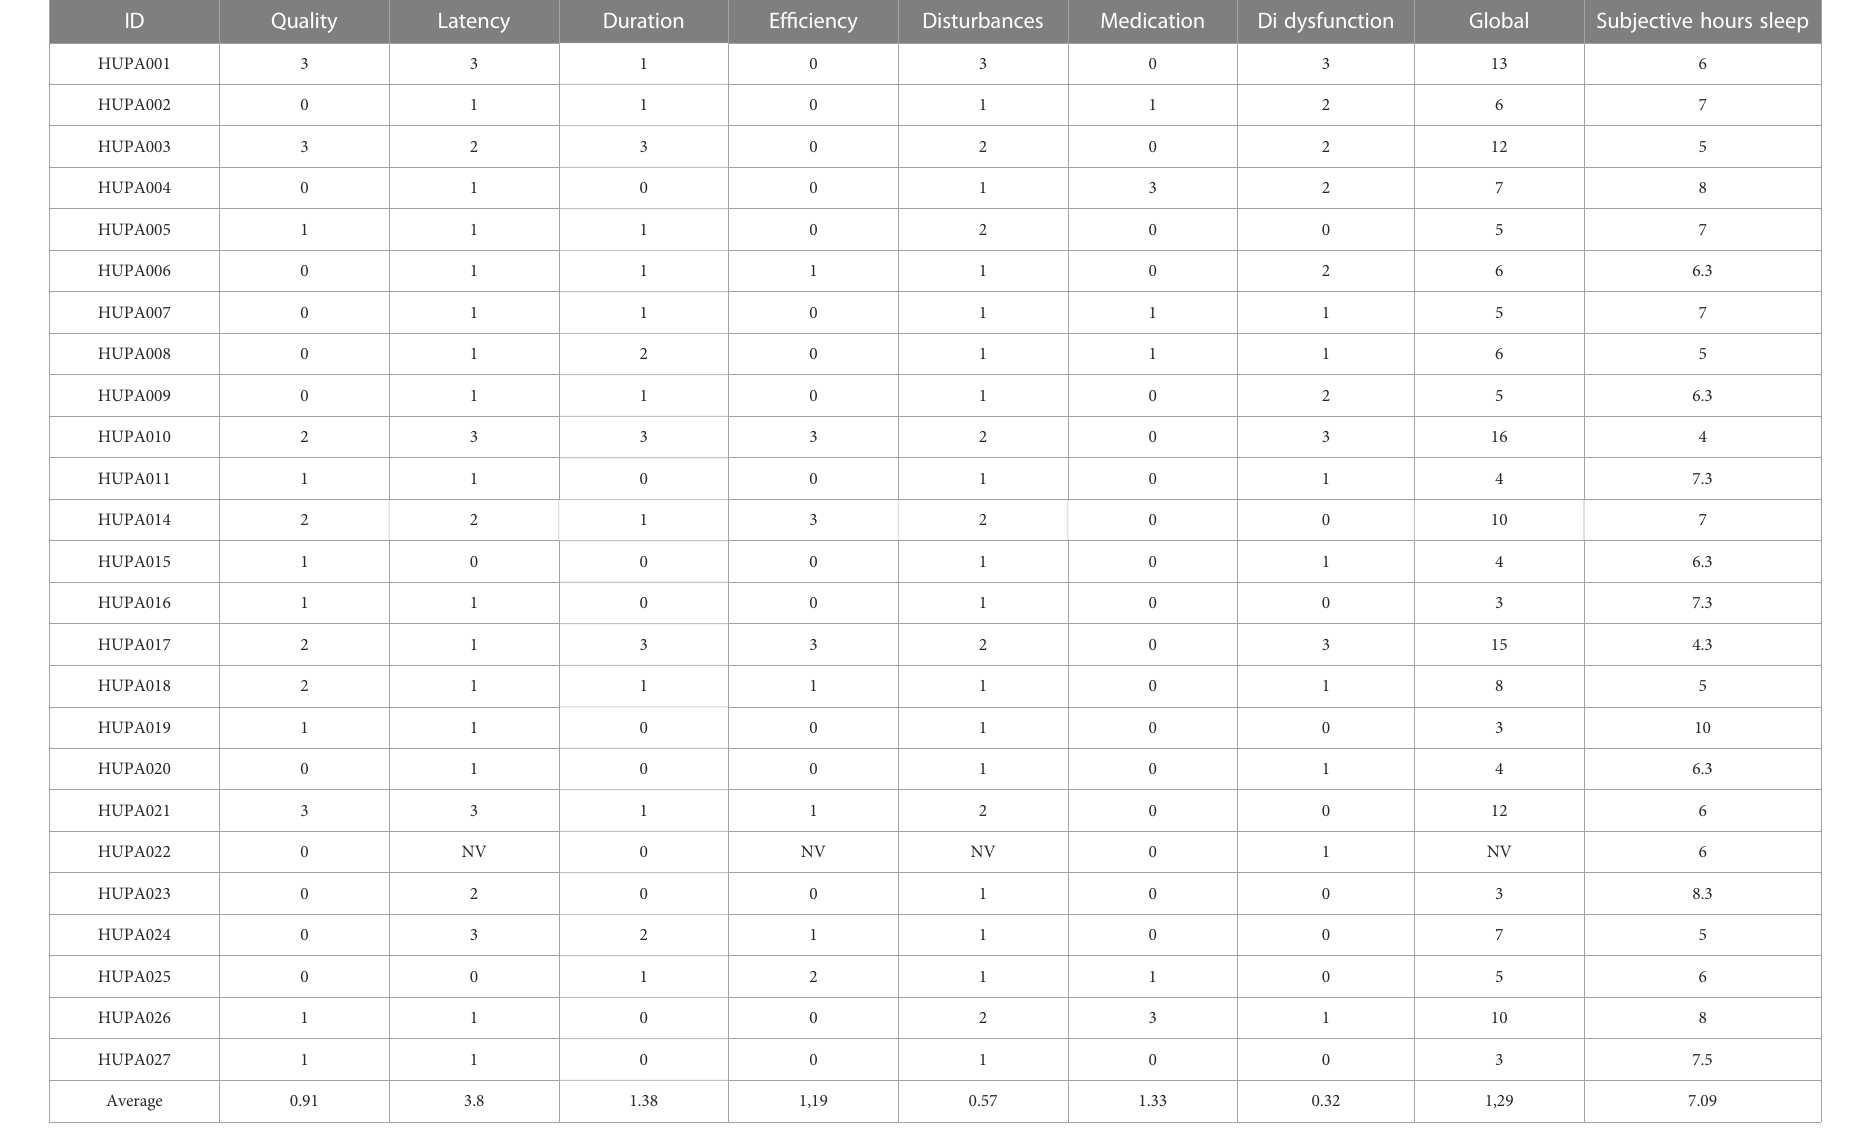
TABLE 2 Results of Pitsburg